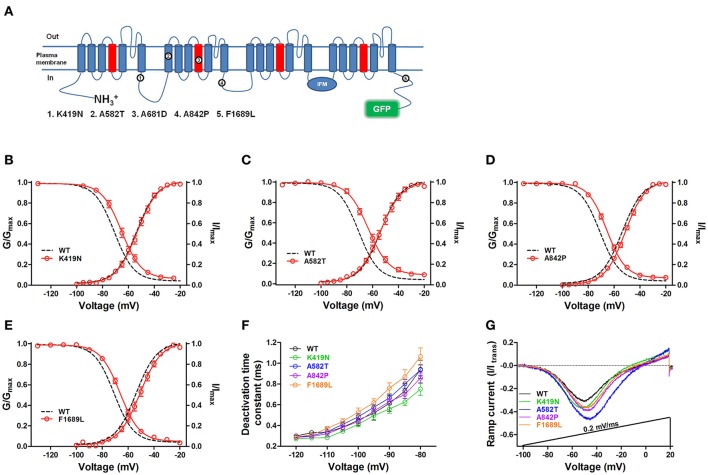
Functional analysis of hNav1.9 mutations by the hNav1.9-GFP heterologous expression system. (A) Membrane topology of Nav1.9-GFP with the position of mutants. Hollowed circles (numbered 1–6) represent amino acid substitutions in hNaV1.9 from individuals with pain disorders. Four mutant channels were functionally expressed in ND7/23 cells. Compared with WT-hNav1.9, the steady-state fast inactivation of the K419N (B), A582T (C), A842P (D), and F1689L (E) mutants were significantly shifted in depolarization direction, but no obvious change of the voltage dependent activation was noticed. (F) The time courses of deactivation of the mutants were not significantly different from that of the WT-channel. (G) Representative ramp currents of the four mutants in response to slow depolarization (0.2 mV/ms) were normalized to the corresponding peak current acquired during activation protocol and plotted as a function of membrane potentials. One micro molar TTX were applied in all experiments.